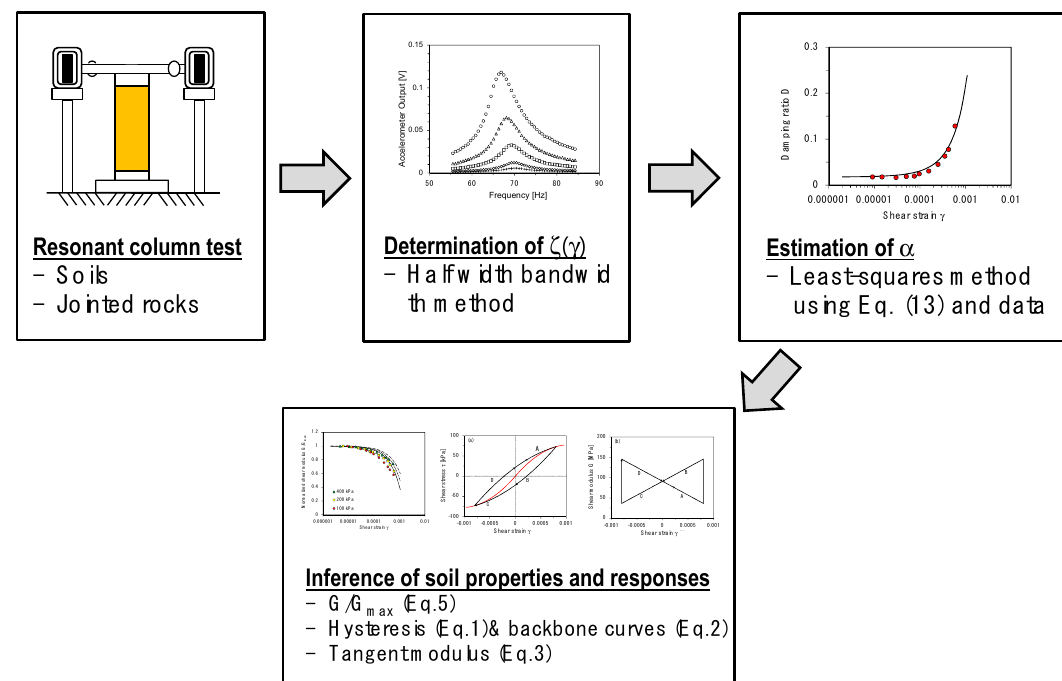
Figure 7. Procedure to characterize the hysteretic soil properties and responses from resonant column test data by applying the analytical model proposed in this study